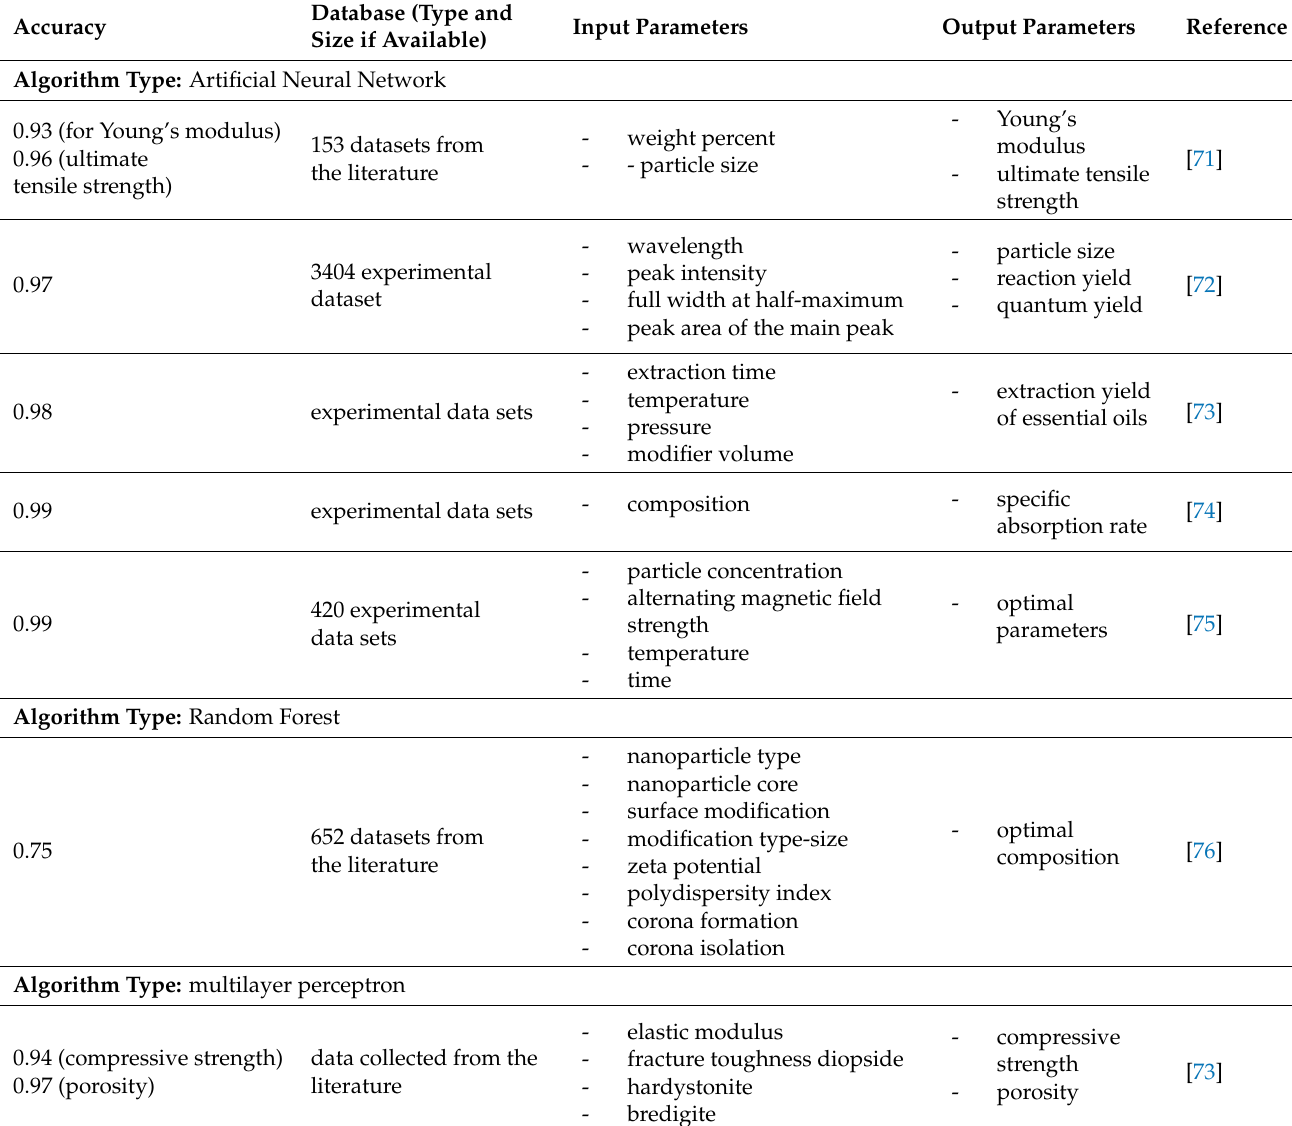
Table 4. The comparison of the algorithms for prediction of the optimal properties of nanomateri- als